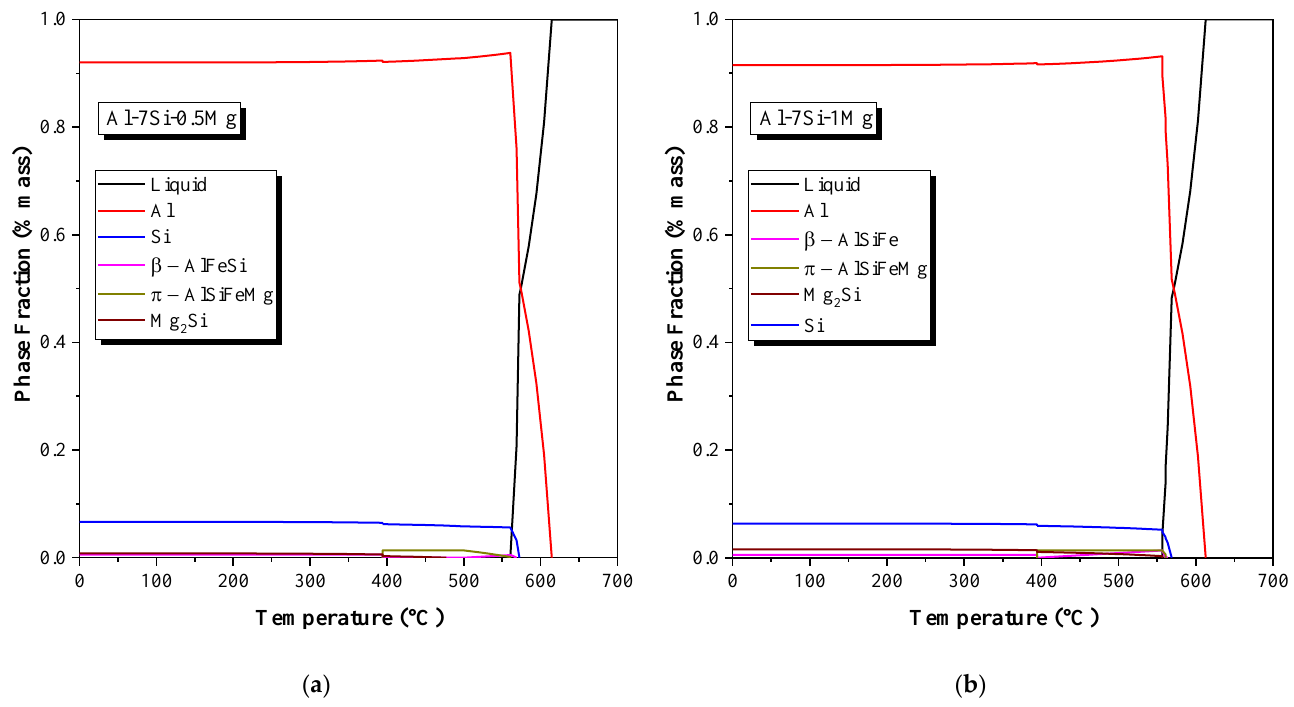
Figure 9. Equilibrium phase fraction plots generated by the Thermo-Calc (with the TTAL5 database) software for the ( a ) Al-7Si-0.5Mg and ( b ) Al-7Si-1Mg alloys. Table 3. Experimental and theoretical values of the mass fractions of the microstructure phases for the studied alloys. Calculated from Experimental Alloy Phase Thermo-Calc